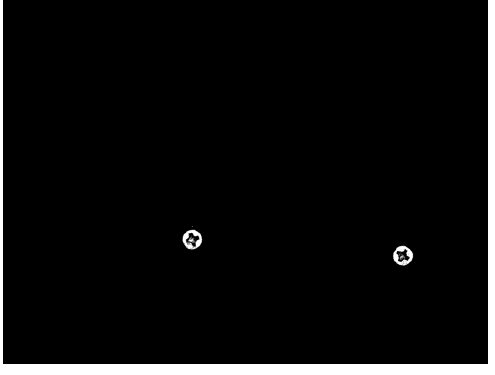
Figure 10. Binarized image.